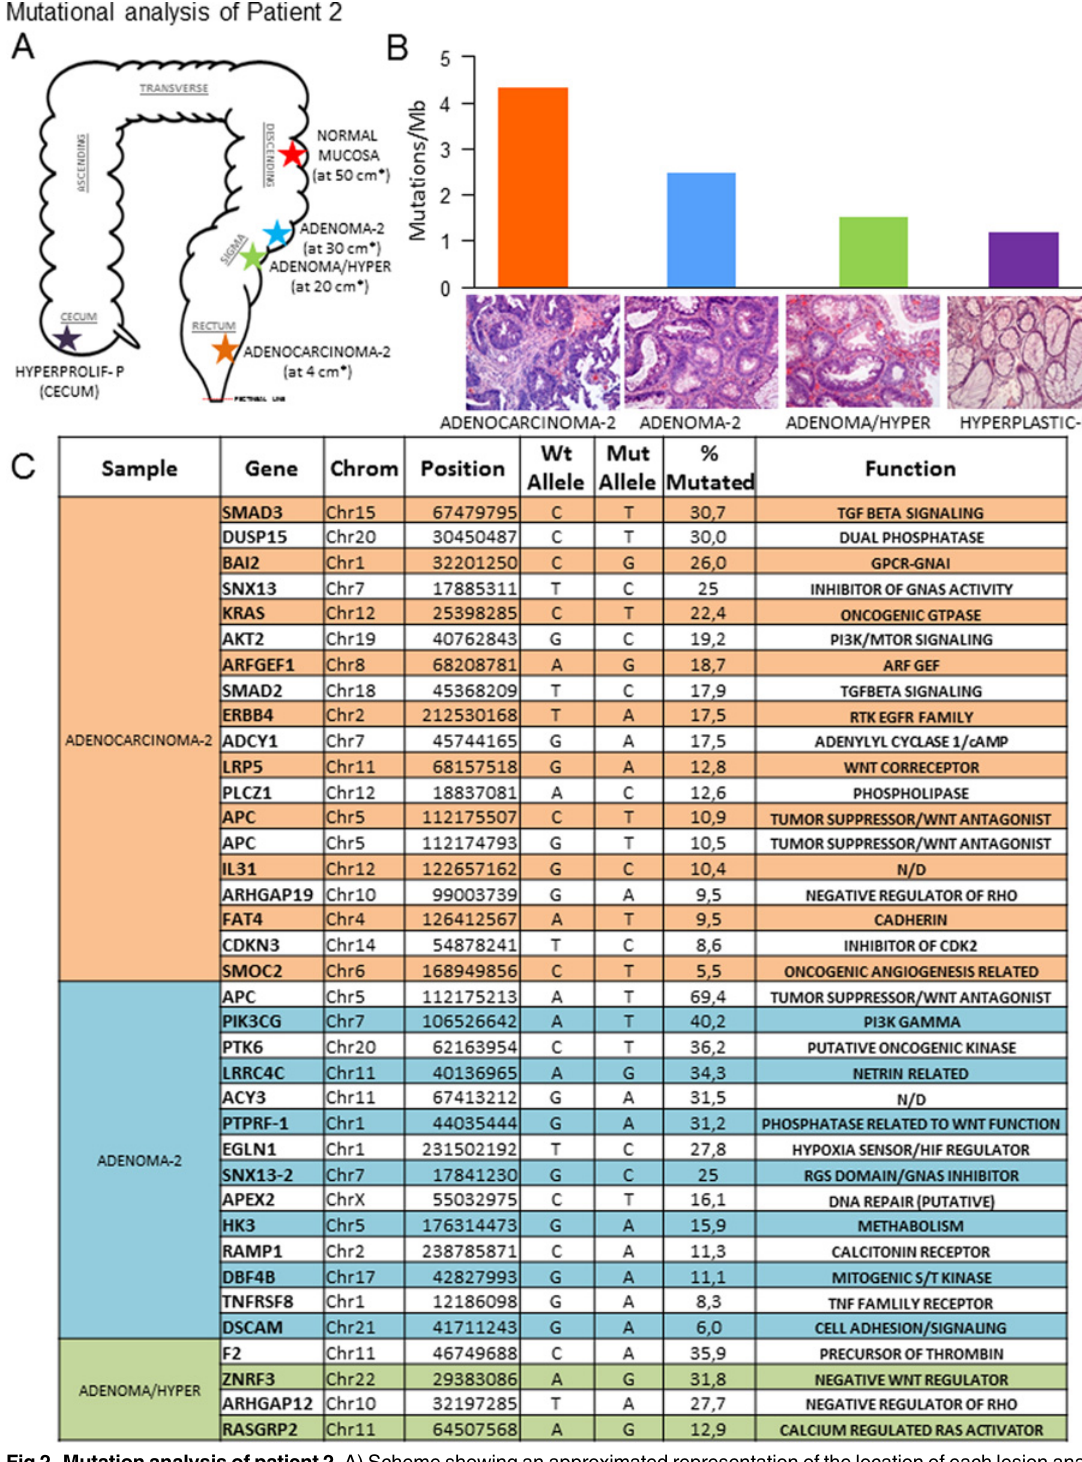
PLOS ONE | DOI:10.1371/journal.pone.0119946 March 16,